Question: What kind of plot is shown here?
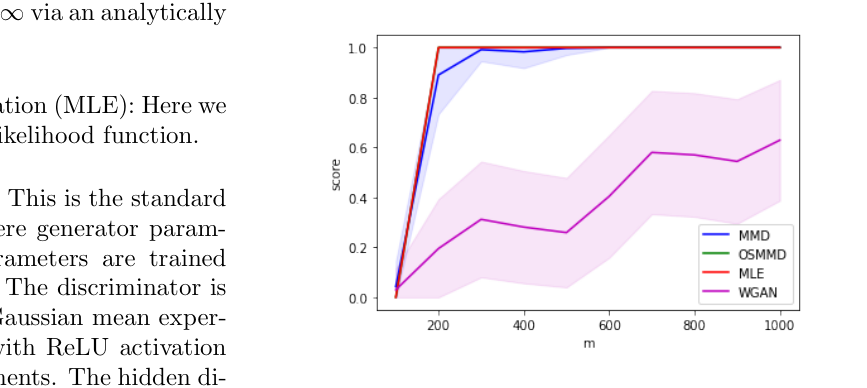
Answer: line